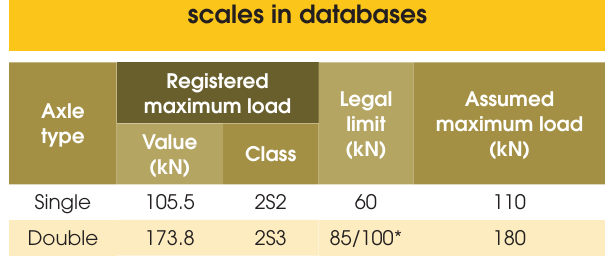
Table 3 – Maximum axle loads recorded by